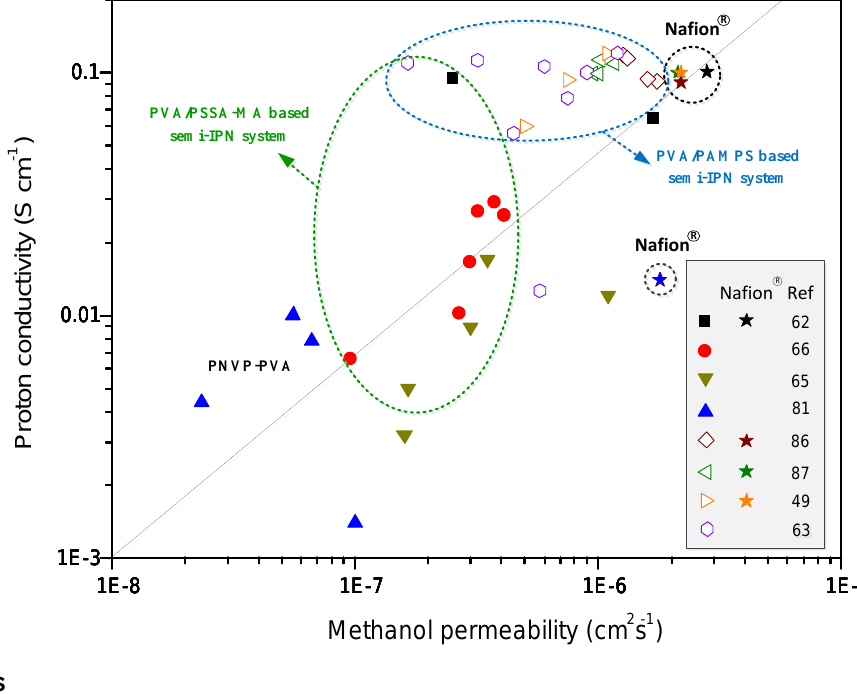
Figure 13. Conductivity versus the methanol permeability of PVA-based semi-IPN membranes. Only values given in the text of articles (rather than values that can merely be read from a figure) are plotted. Various Nafion ® values are plotted for